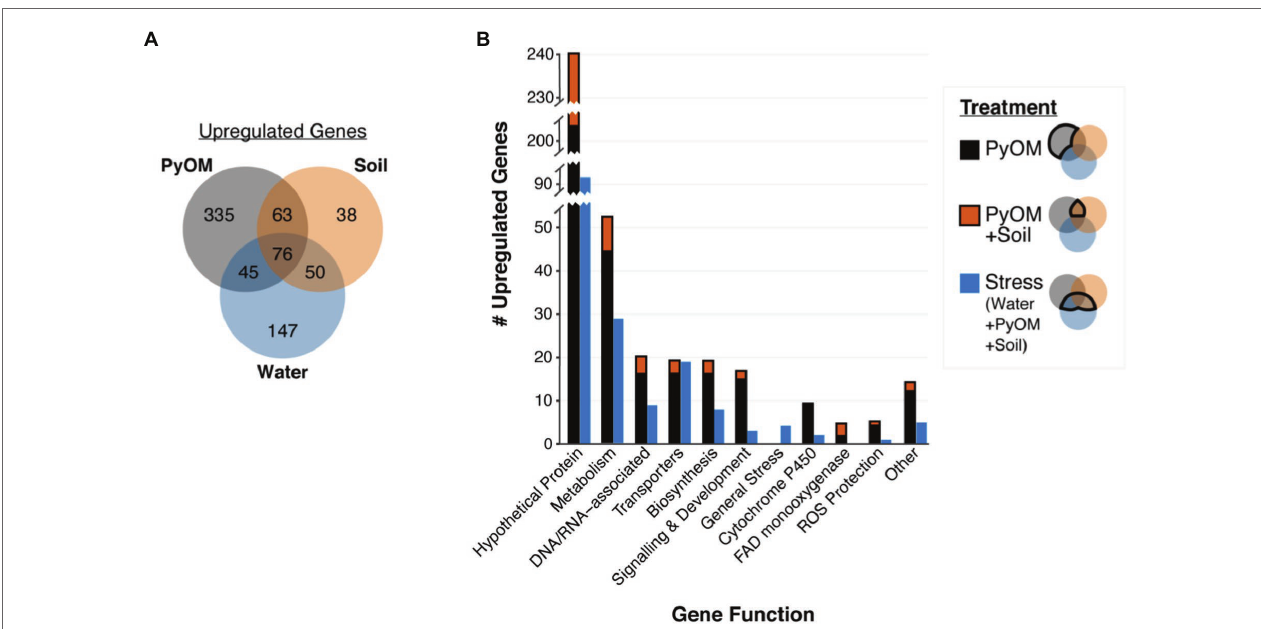
FIGURE 3 | Pyrolyzed substrates induce expression of genes involved in stress response and PyOM metabolism. (A) Venn diagram showing the number of significantly upregulated genes in each treatment compared to sucrose (adjusted value of p < 0.01, fold change > 4, n = 3). (B) Number of significantly upregulated genes compared to expression on sucrose in each functional gene category (adjusted value of p < 0.01, fold change > 4, n = 3). Functional gene categories were determined via KEGG, GO, and pfam annotations. Stacked black and orange bars indicate the number of genes upregulated on PyOM alone (black) or the overlap between PyOM and soil (orange and black). We defined stress-response genes as those which are upregulated on water agar. Blue bars indicate the number of genes that are upregulated on both water and burned or pyrolyzed substrates for each functional